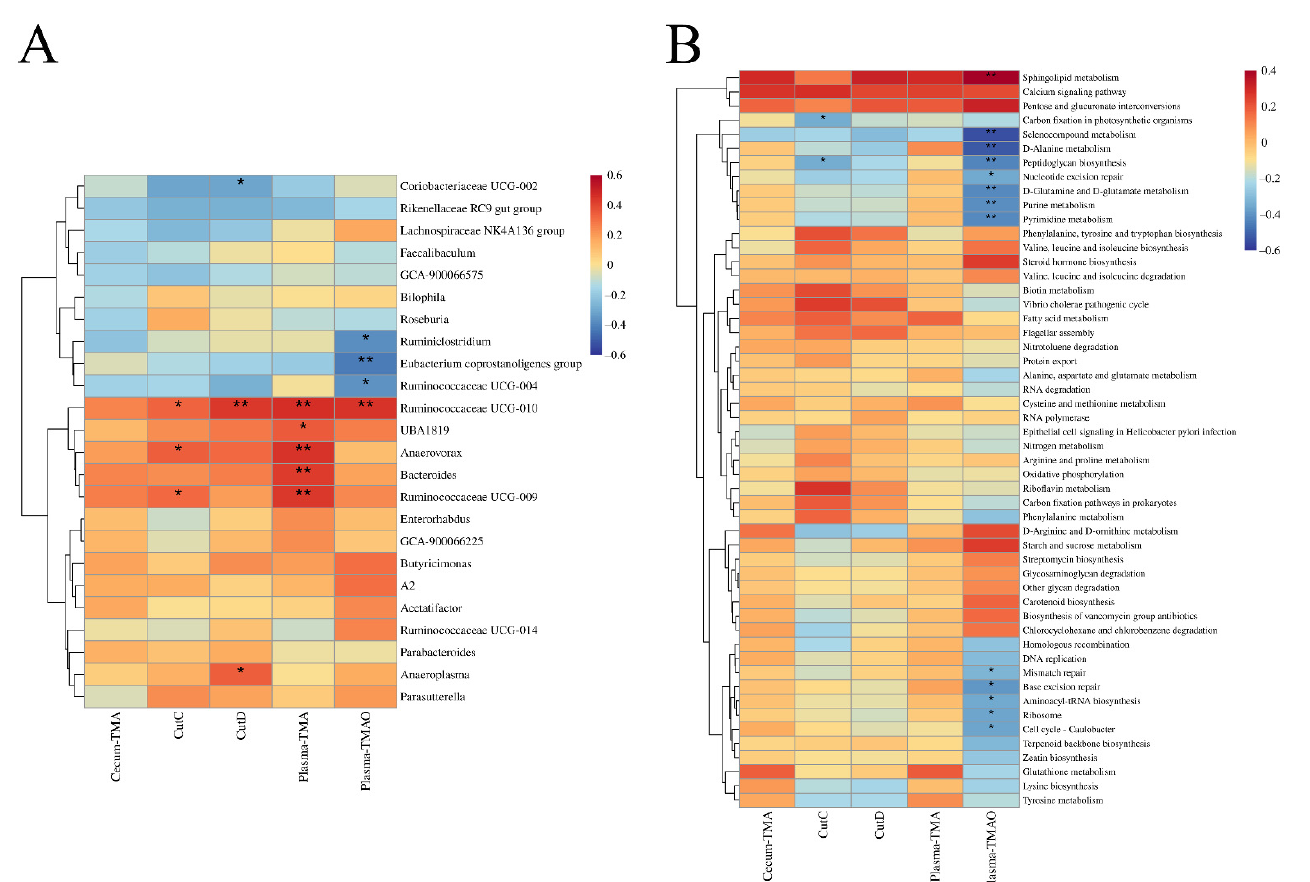
Figure 8. Bifidobacterium remodeled the structure of the gut microbiota then regulated the potential function of the gut microbiota: ( A ) correlation among plasma TMAO, plasma TMA, cecum TMA, the expression levels of cecum CutC and CutD and genus with significant differences; ( B ) correlation between plasma TMAO, plasma TMA, cecum TMA, the expression levels of cecum CutC and CutD and the pathway/function with significant differences. * p < 0.05, ** p < 0.01.